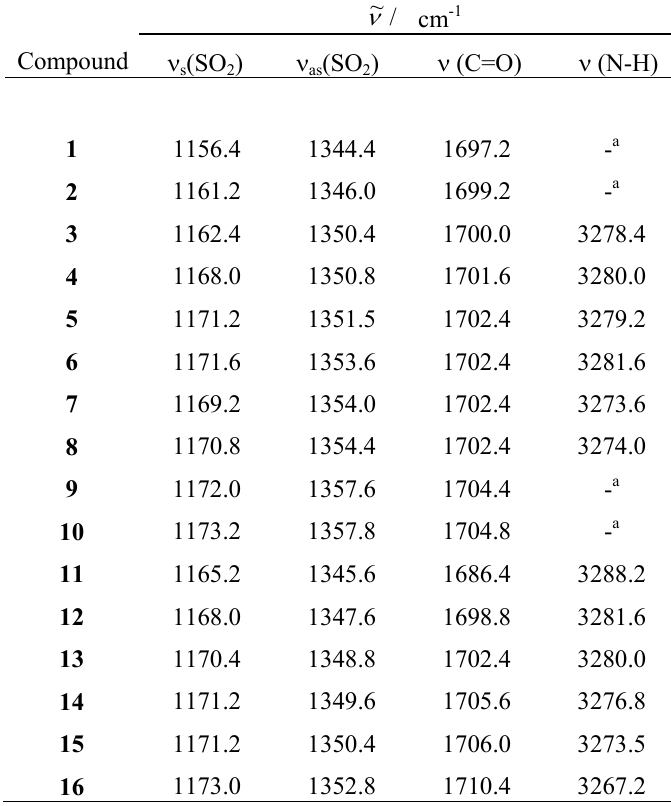
Table 1. Characteristic infrared spectral data for substituted N -phenylsulfonylbenzamides